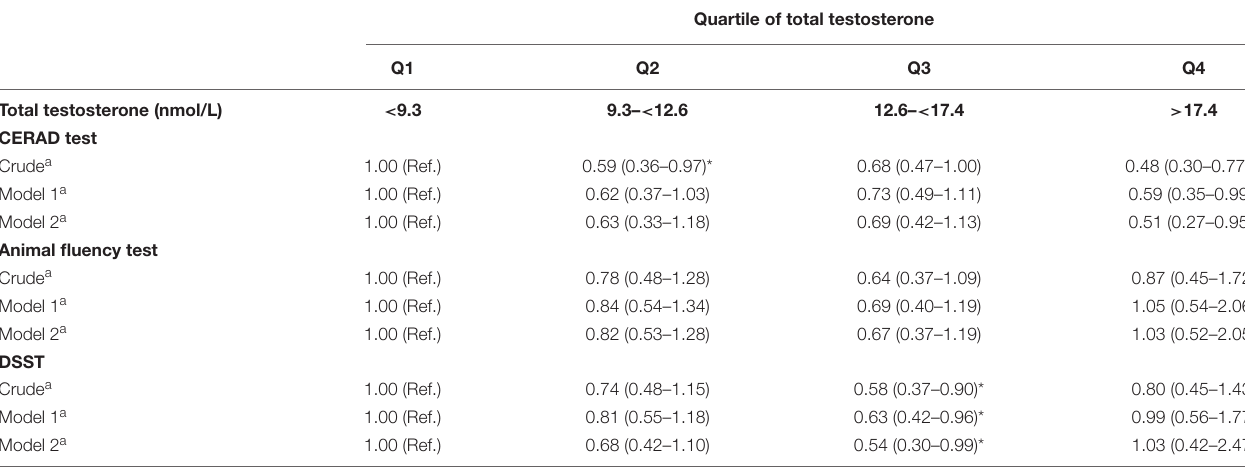
TABLE 2 | Weighted odds ratios (95% confidence intervals) for score on CERAD, animal fluency and DSST test across quartiles of total testosterone in men, NHANES 2011–2014 ( N = 1,303).